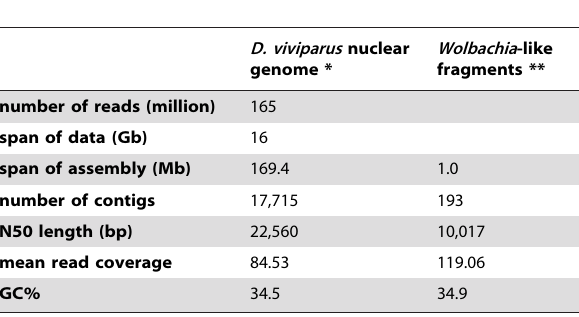
Table 1. Assembly statistics for the Dictyocaulus viviparus nuclear genome and the Wolbachia -like insertions.